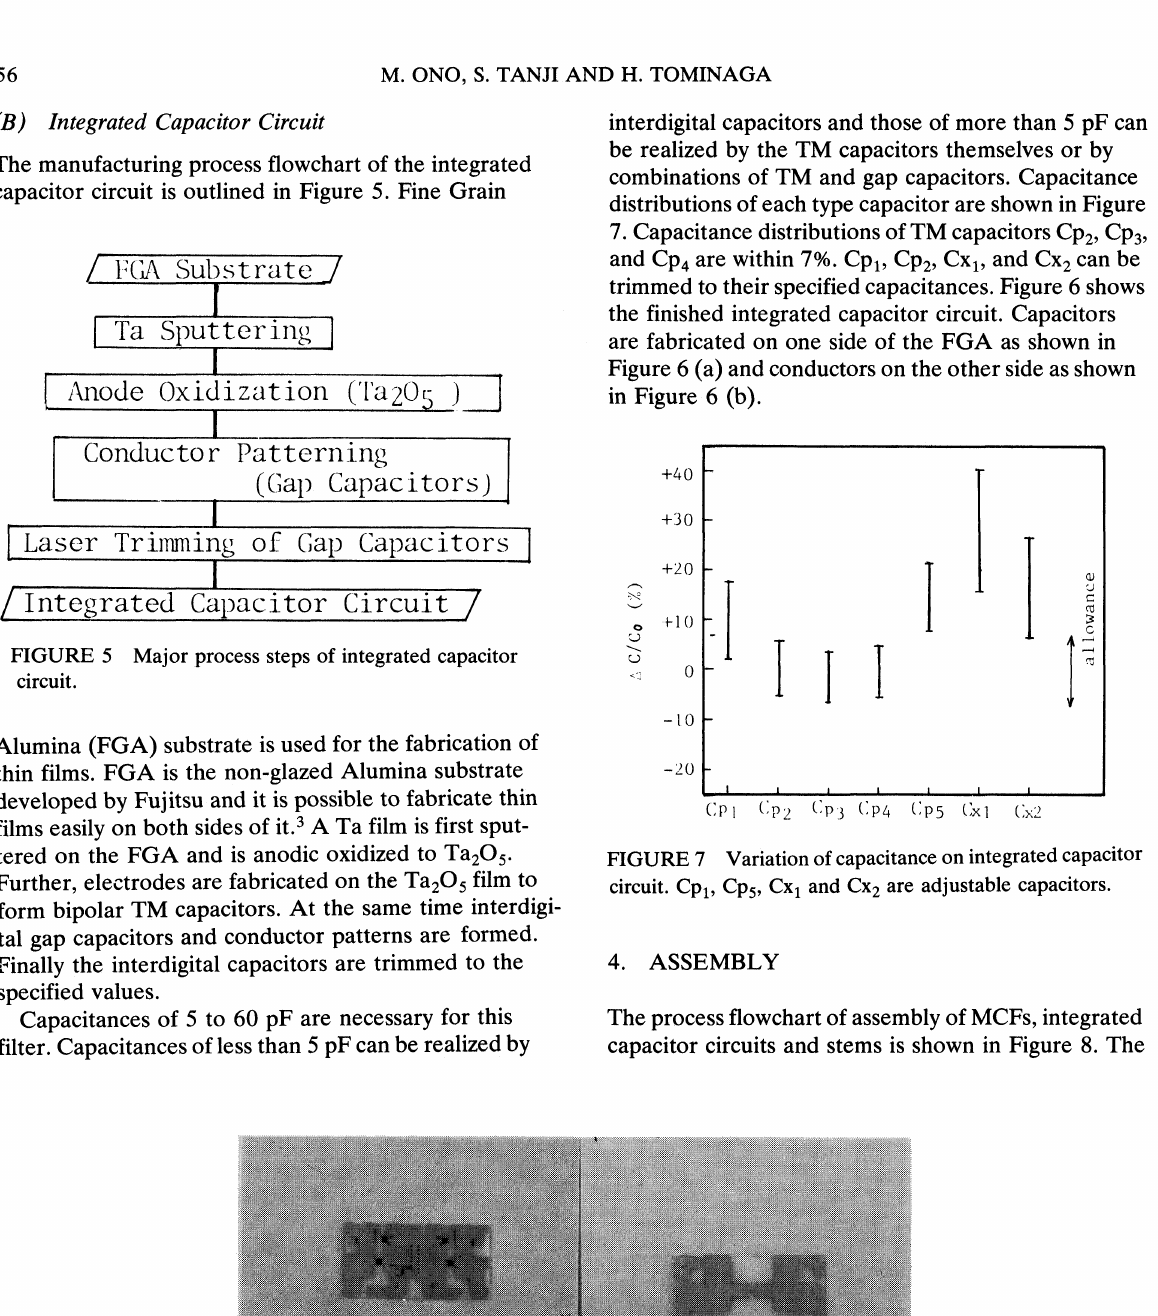
FIGURE 6 Configuration of integrated capacitor circuit. 6 Ta205 thin film capacitors and 4 gap capacitors on the top side, and only the conductor pattern on the bottom